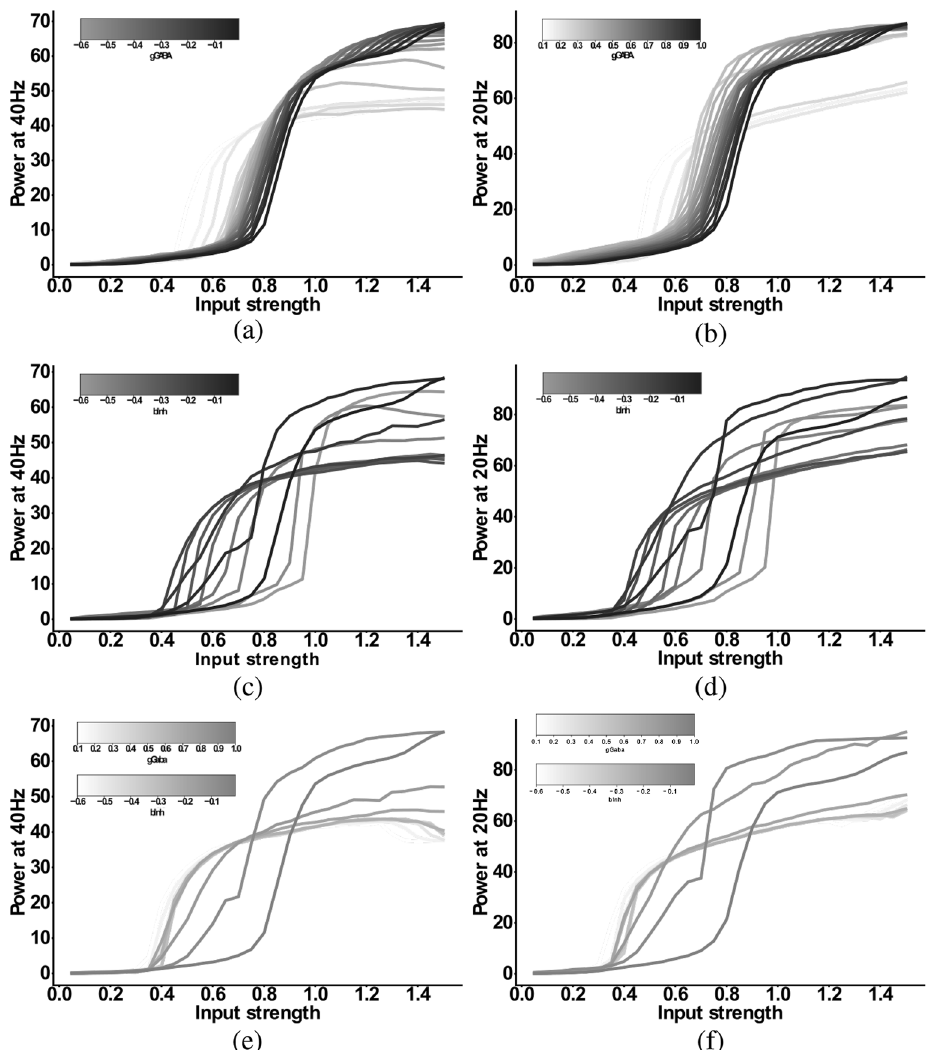
Figure 7. Input strength dependence of the response to 20 Hz drive in the three different models: ( a ) and ( b ) ‘IPSC+gGABA-SCZ-like’, ( c ) and ( d ) ‘IPSC+bInh-SCZ-like’ and, ( e ) and ( f ) ‘Full-SCZ-like’. ( a ), ( c ) and ( e ) Power at 40 Hz in response to 20 Hz drive as a function of the input strength. ( b ), ( d ) and ( f ) Power at 20 Hz in response to 20 Hz drive as a function of the input strength. In all plots the network model has increased IPSC decay times (from 8 to 28 ms). In ( a ) and ( b ) the I-E and I-I synaptic strength ( g ie and g ii , respectively) is varied from 100% (black) to 10% (lightest grey) in steps of 5%. In ( c ) and ( d ) the interneuron excitability b inh is varied from − 0.01 (black) to − 0.1 (darkest grey) and then in steps of − 0.05 to − 0.6 (lightest grey). In ( e ) and ( f ) now both the I-E and I-I synaptic strength ( g ie and g ii , respectively) is varied from 100% (black) to 10% (lightest grey) in steps of 10% and simultaneously the interneuron excitability b inh is varied from − 0.01 (black) to − 0.1 (darkest grey) and then in steps of − 0.05 to − 0.6 (lightest